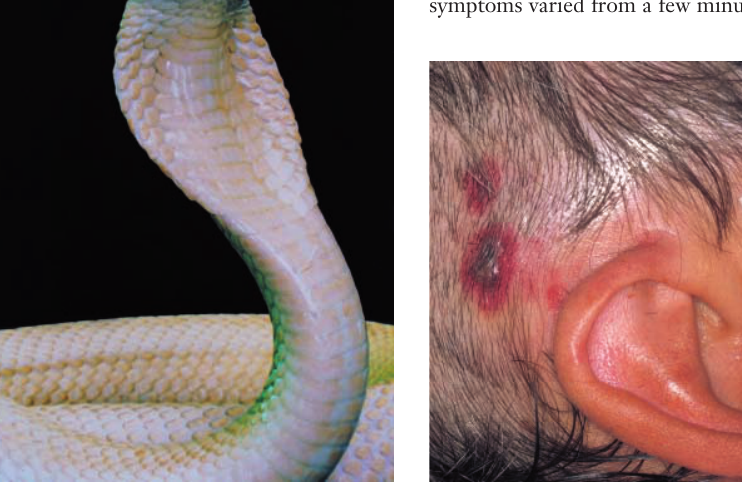
Bite wound of Patient 2; note the necrosis around the bite